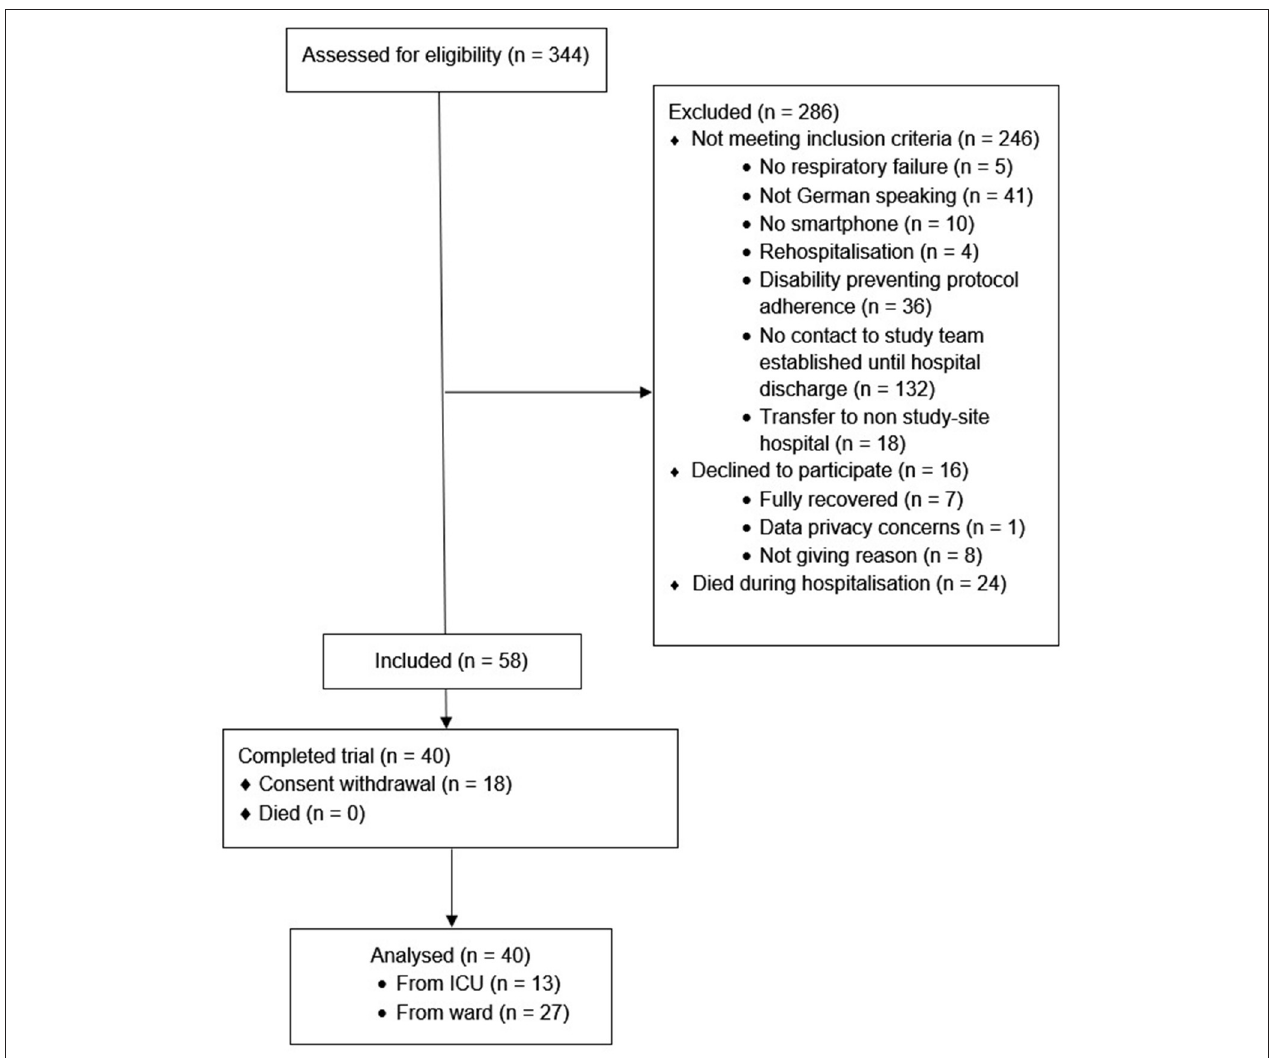
FIGURE 1 | Study participant flow